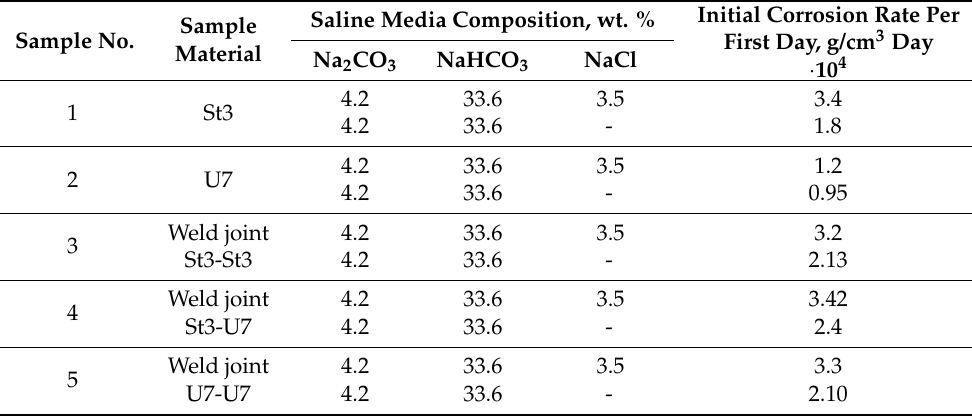
Table 2. Summary data on the study of structural materials corrosion resistance. Sample